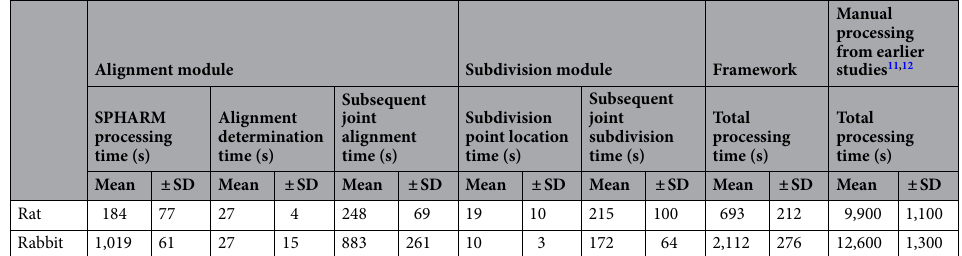
Table 5. CPU time for each process of the pipeline expressed in mean (± SD) seconds. Total time for manual processing performed in earlier studies is shown on the last column for